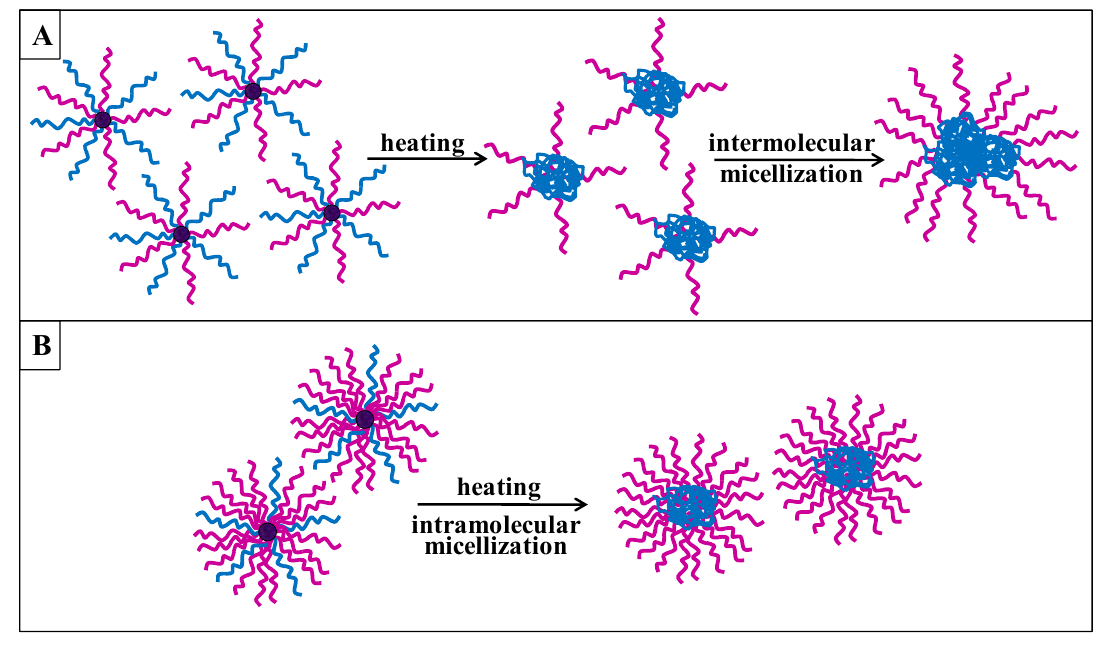
Scheme 2. Thermo-induced micellization behavior of the PNIPAM (A) For relative small number of PEG arms, multimolecular micelles were formed. (B)